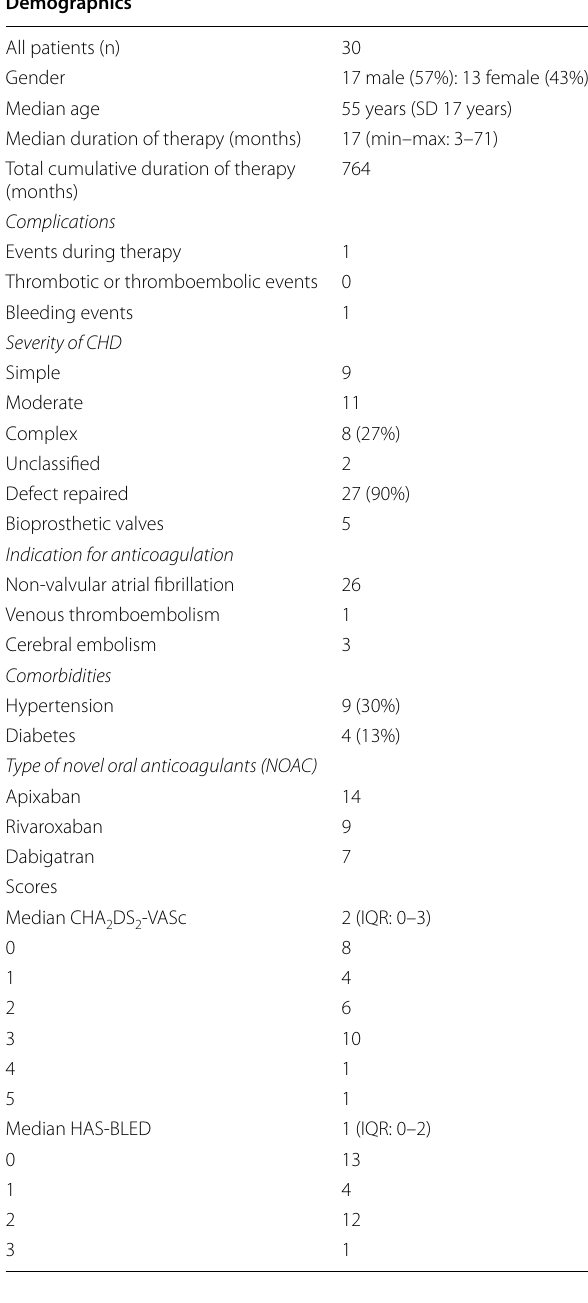
Table 2 Causes for discontinued novel oral DS -VASc and HAS-BLED 2 2